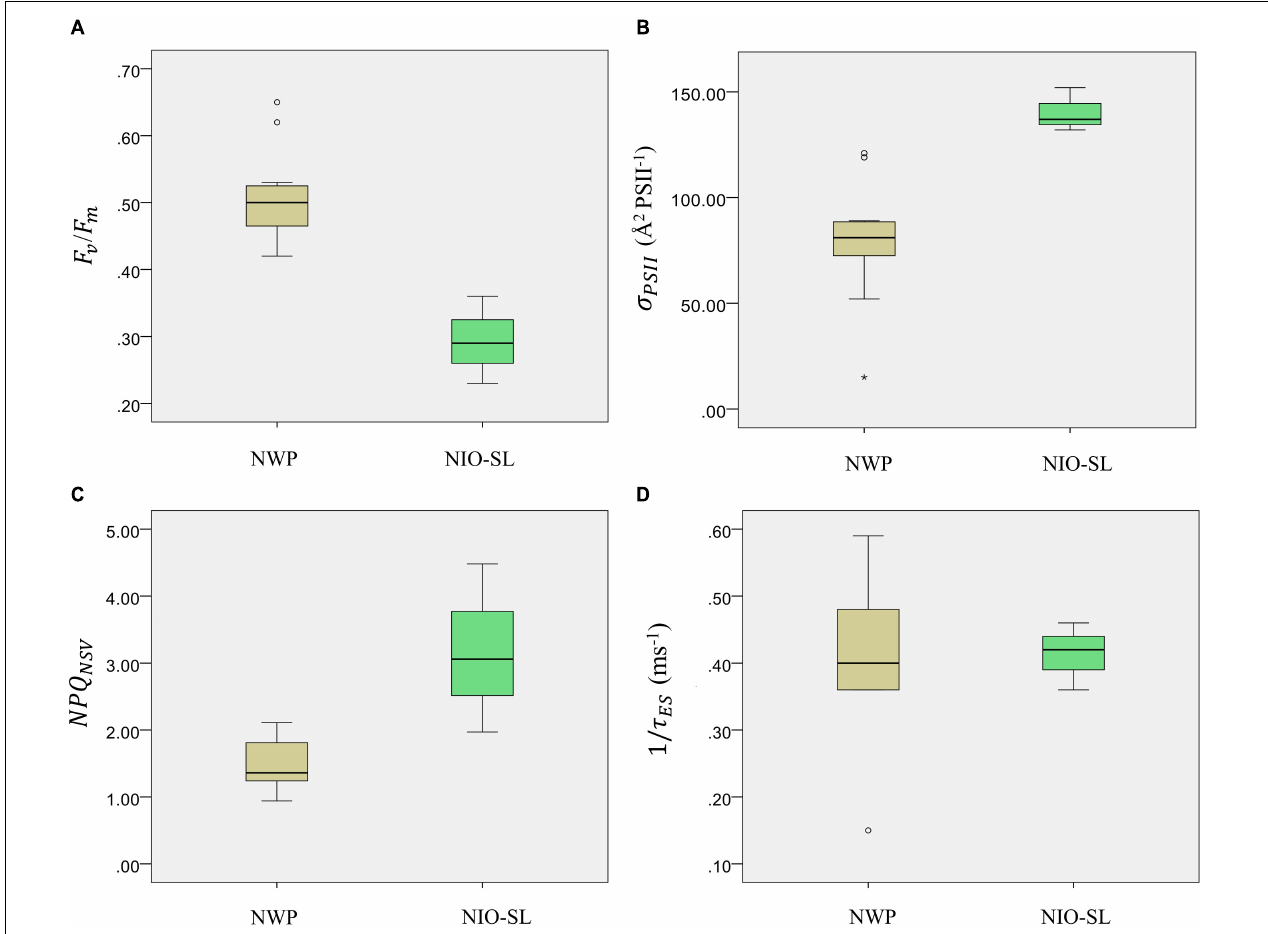
FIGURE 4 | Boxplots of Trichodesmium photophysiological parameters (A) PSII maximum photochemical efficiency, F v / F m , (B) functional absorption cross section of PSII, σ PSII (Å 2 PSII − 1 ), (C) normalized Stern–Volmer non-photochemical quenching NPQ NSV and (D) PSII turnover time 1 / τ ES (ms − 1 ) within NWP and NIO-SL regions. * indicates the extreme